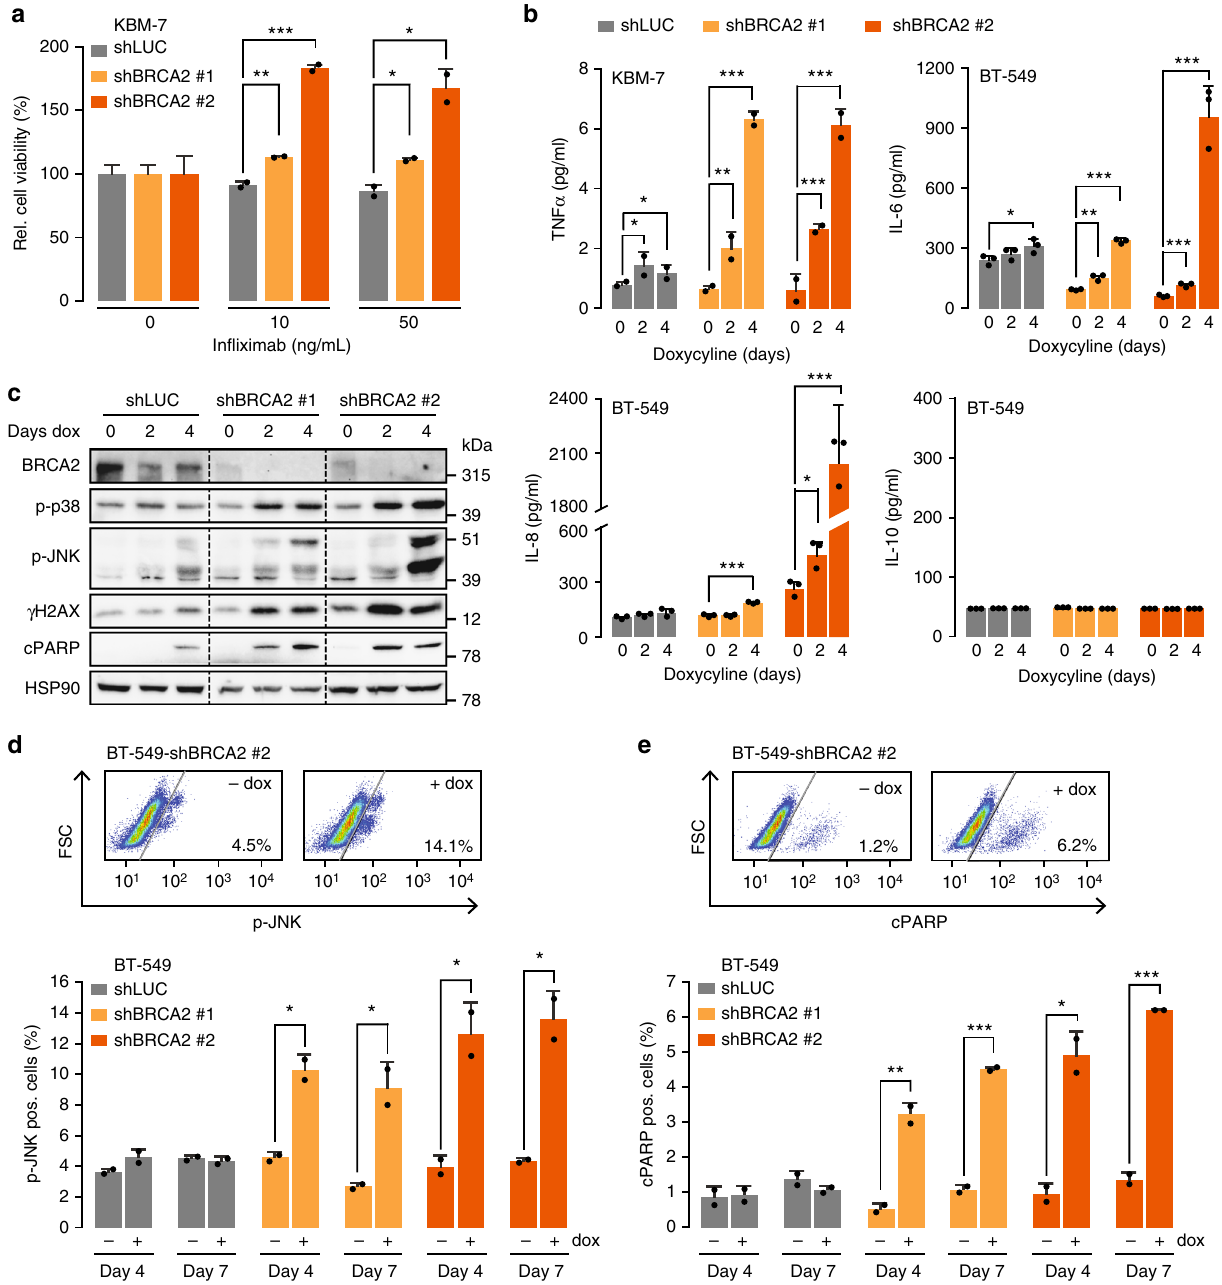
Fig. 3 BRCA2 depletion results in increased TNF α signaling. a KBM-7 cells harboring indicated shRNAs were treated with doxycycline for 48 h and subsequently plated and treated with indicated concentrations of in fl iximab for 5 days. Error bars indicate s.d. of two independent experiments. b Levels of TNF α , IL-6, IL-8 and IL-10 secretion upon BRCA2 depletion. After 0, 2 or 4 days of doxycycline treatment, medium was harvested. TNF α was measured using ELISA. IL-6, IL-8 and IL-10 were measured using bead-arrays. Error bars indicate s.d. of two or three independent experiments. c Immunoblotting of BT-549 cells harboring indicated shRNAs after 0, 2 or 4 days of doxycycline treatment. Levels of p-p38, p-JNK, γ H2AX, cleaved PARP ( ‘ cPARP ’ ) and HSP90 were analyzed. Both JNK isoforms (p46 and p54) are indicated. Dotted lines are used to indicate different shRNAs. d BT-549 cells harboring indicated shRNAs were treated with doxycycline for the indicated time periods, and analyzed by fl ow cytometry for p-JNK expression. Gating was performed as shown in the top panel. Numbers indicate the percentages of living cells stained positive for p-JNK. Error bars indicate s.d. of two independent experiments. e BT-549 cells were treated as described in d . Cells were analyzed by fl ow cytometry for cleaved PARP. Gating was performed as shown in the top panel. Numbers indicate the percentages of living cells stained positive for cleaved PARP. Error bars indicate s.d. of two independent experiments. Throughout the fi gure, P values were calculated using two-tailed Student ’ s t -test. * P < 0.05, ** P < 0.01, *** P <